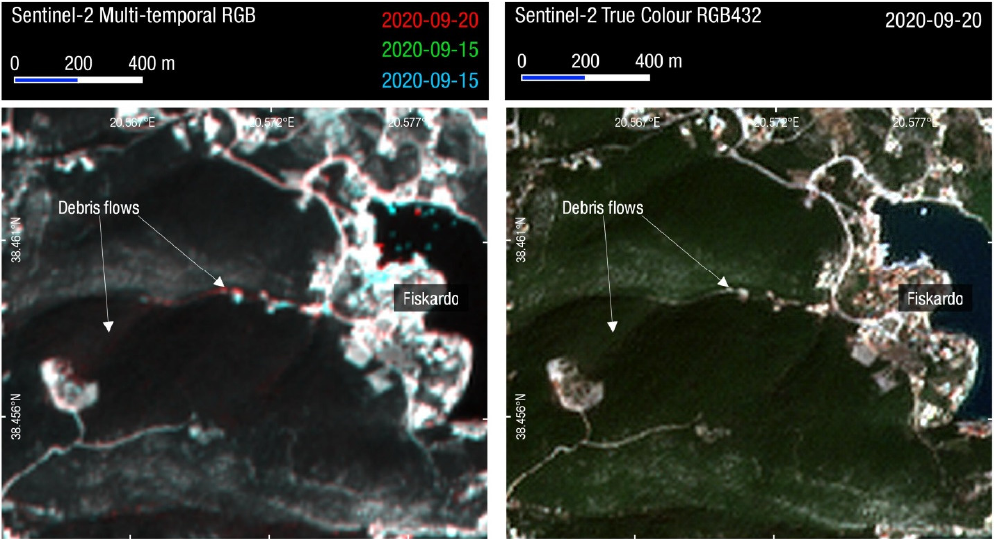
Figure 13. ( Left ): Sentinel-2 multi-temporal composite (Band 4) Fiskardo, Cephalonia. ( Right ): Sentinel-2 true color composite (Bands 4-3-2). Red colors mark the location of debris flows upstream of Fiskardo.